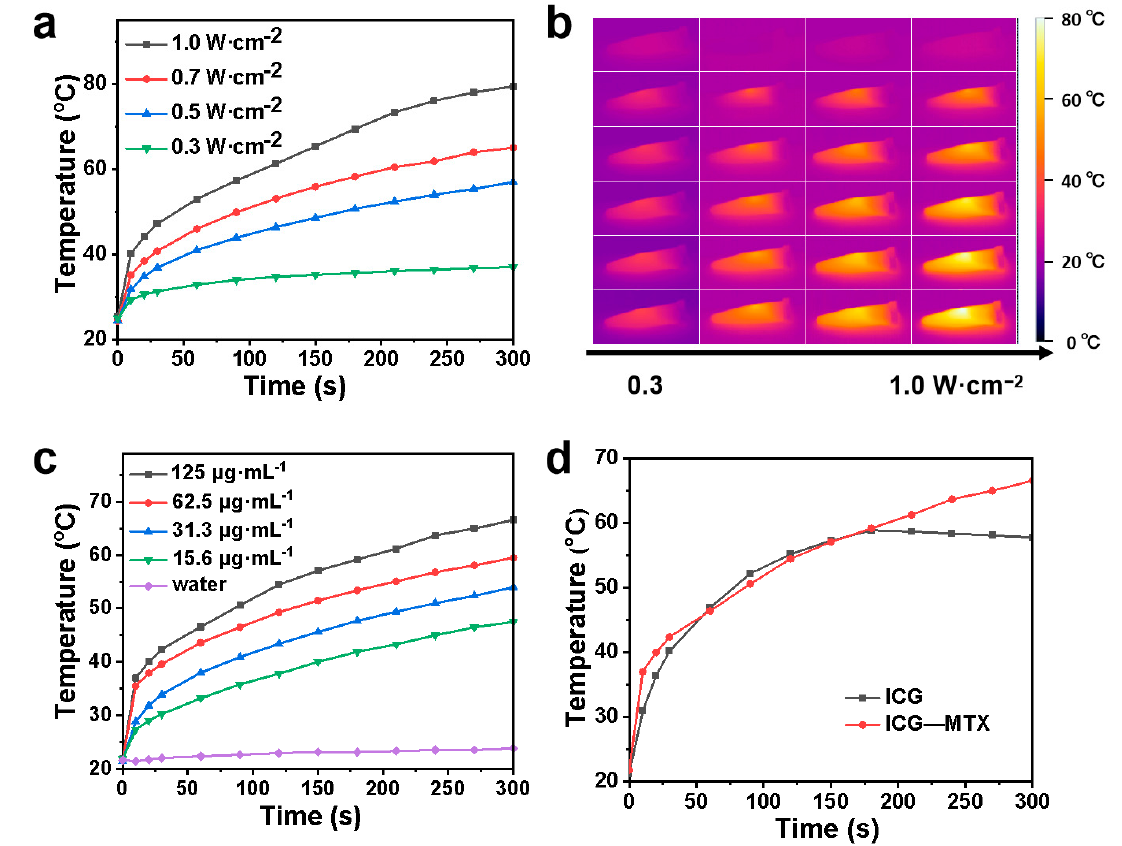
Figure 3. The photothermal performance of ICG—MTX. ( a ) The photothermal performance of ICG—MTX (31.3 µ g · mL − 1 ) under irradiation of 808 nm lasers with different laser power intensities. ( b ) Infrared thermal images of ICG—MTX (ICG, 31.3 µ g · mL − 1 ) under irradiation of different laser power of 808 nm laser. ( c ) The photothermal performance of different concentrations of ICG—MTX under 808 nm laser irradiation at 0.5 W · cm − 2 . ( d ) The photothermal effect of ICG (31.3 µ g · mL − 1 ) and ICG—MTX (ICG, 31.3 µ g · mL − 1 ) solutions under 808 nm laser irradiation (0.5 W · cm − 2